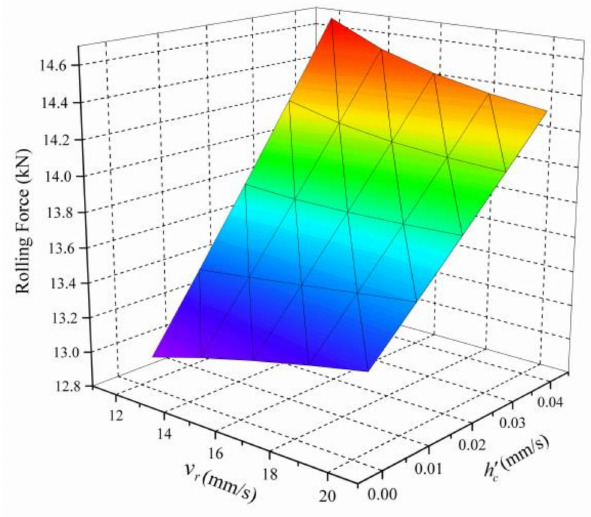
Figure 9. The influence of rolling velocity and roll gap reduction velocity on rolling force (2 h 1 = 1.816 mm).